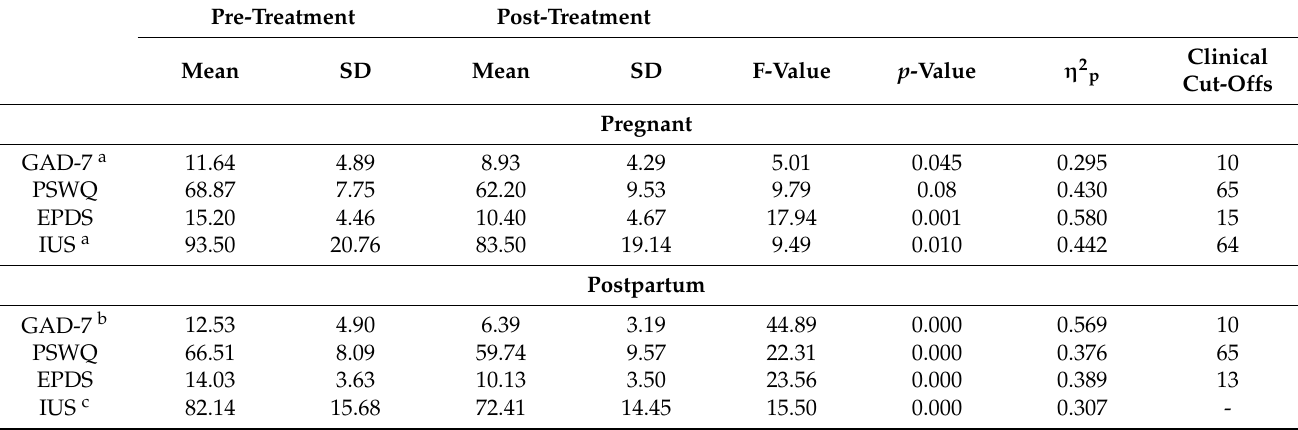
Table 3. Pre-toPost-TreatmentSymptomChangeinPregnant( n =15)andPostpartum( n